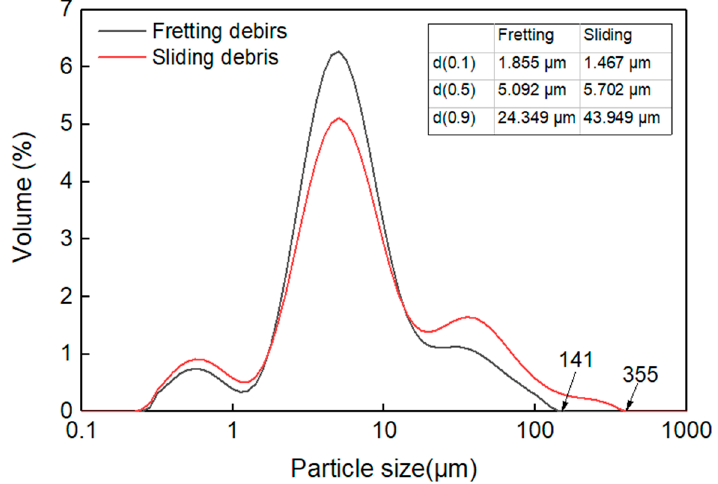
Figure 8. Particle size distribution of the wear debris.